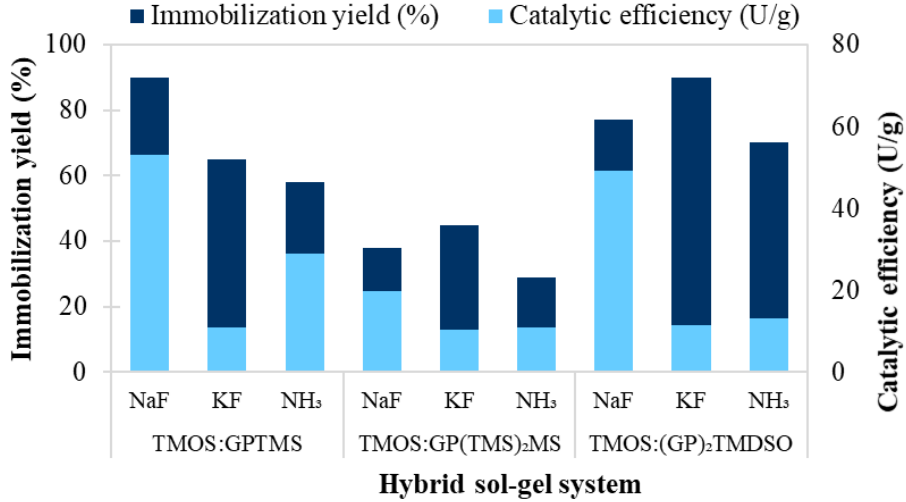
Figure 1. The influence of the silane system and catalyst type on the immobilization yield and catalytic efficiency of sol-gel-entrapped Candida antarctica B lipase.